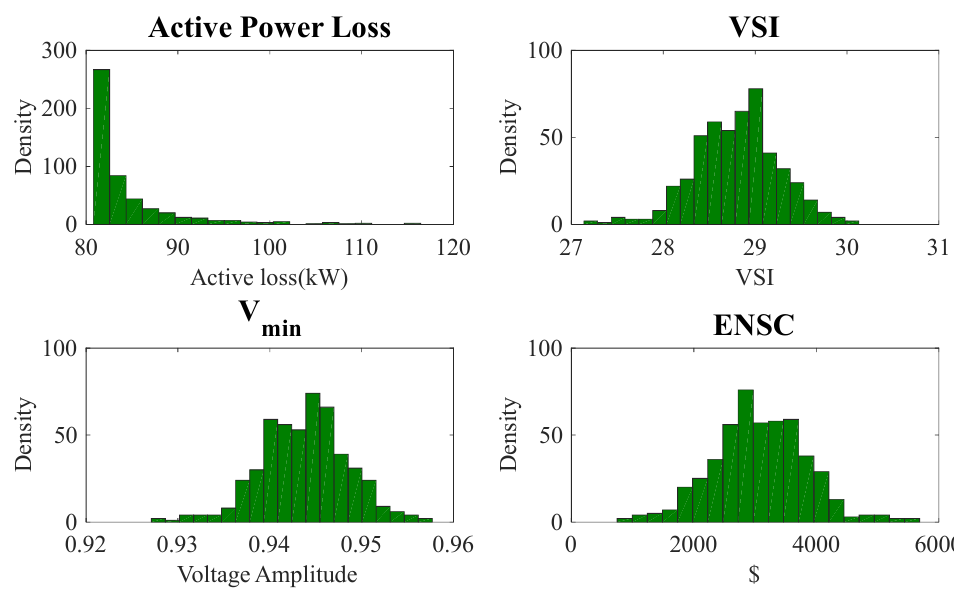
Figure 8. PDF of each objective based on SMM. Table 5. The results of multi-criteria wind turbine allocation in a 33-bus network based on SMM.